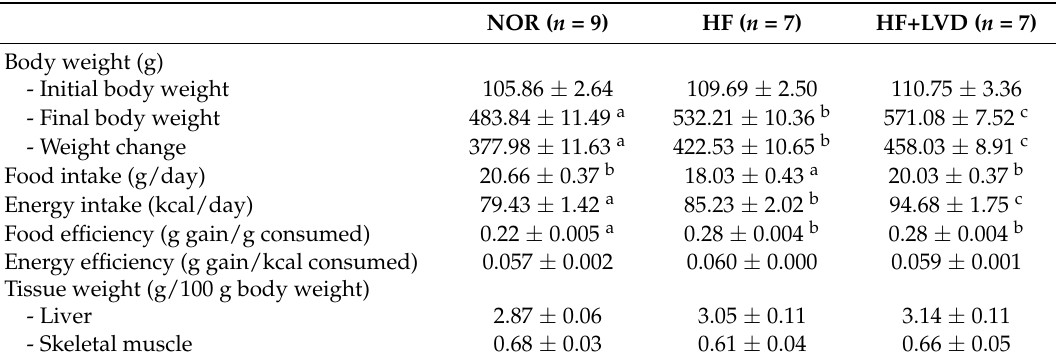
Table 3. Effects of vitamin D on body weight, food intake and tissue